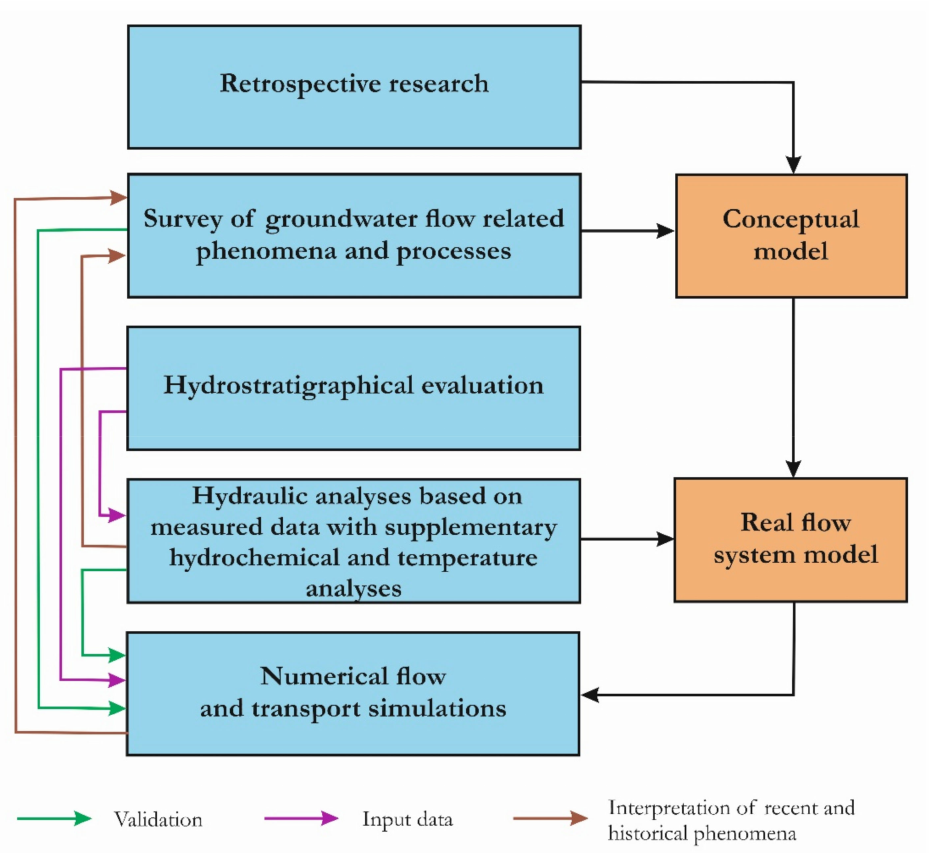
Figure 5. Workflow for basin-scale groundwater flow system evaluation (modified after [50]) (see Table 2 for details).